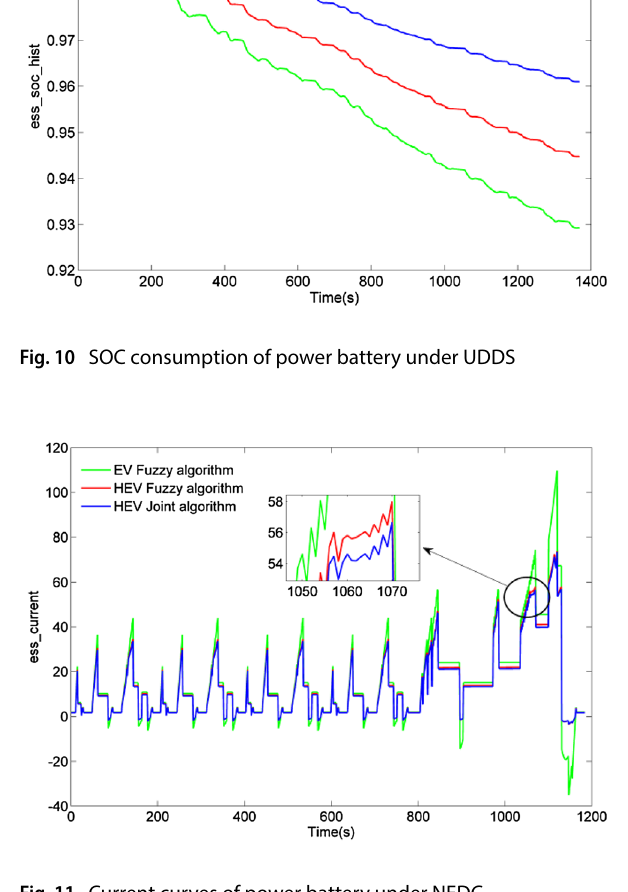
Fig. 11 Current curves of power battery under NEDC